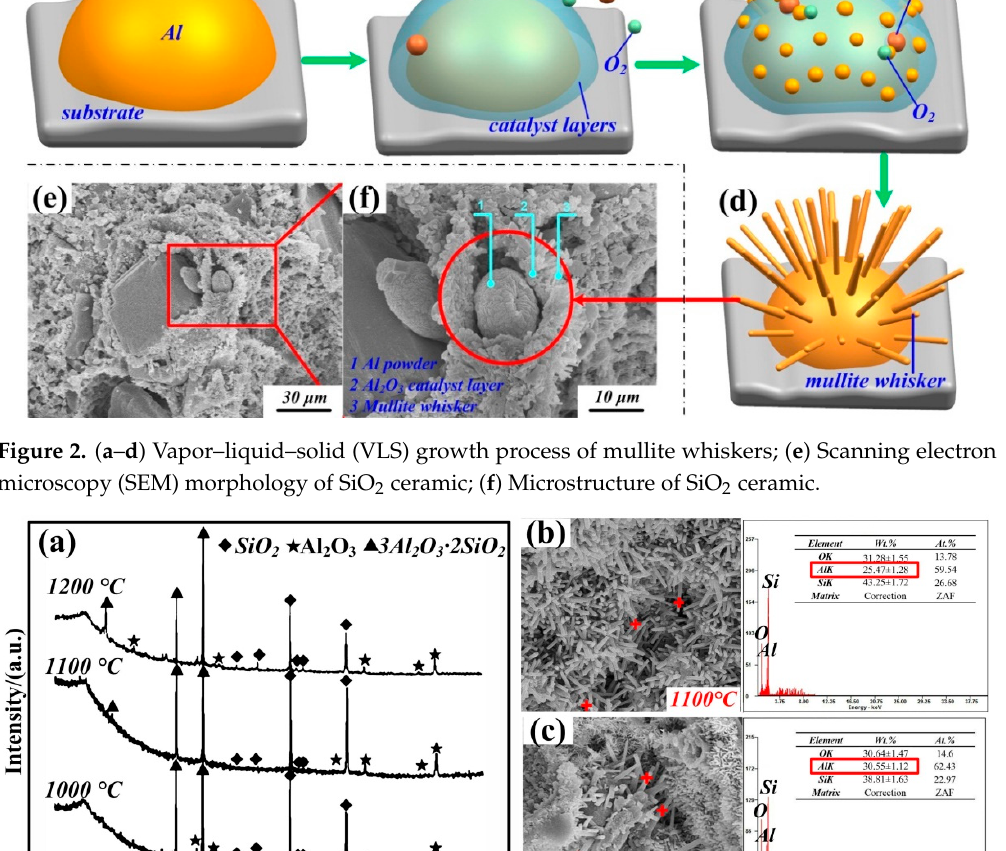
Figure 2. ( a – d ) Vapor–liquid–solid (VLS) growth process of mullite whiskers; ( e ) Scanning electron microscopy (SEM) morphology of SiO 2 ceramic; ( f ) Microstructure of SiO 2 ceramic.